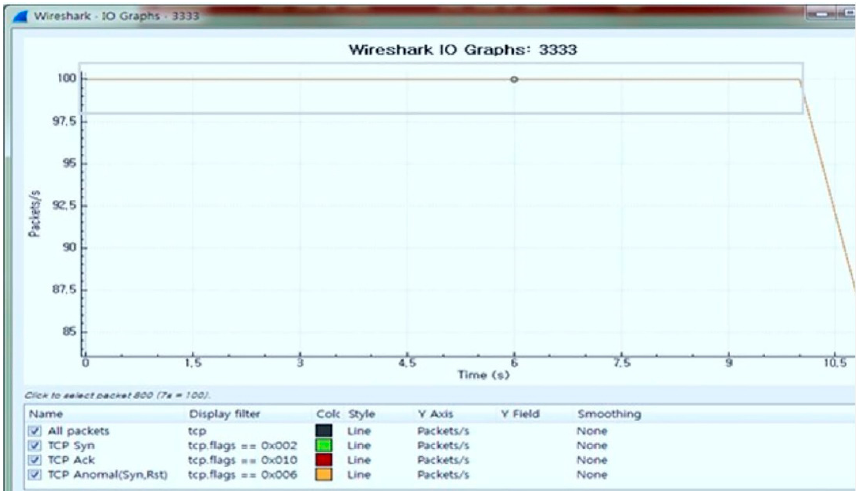
Figure 7. Packet with modulated source from M2M intelligent network device.